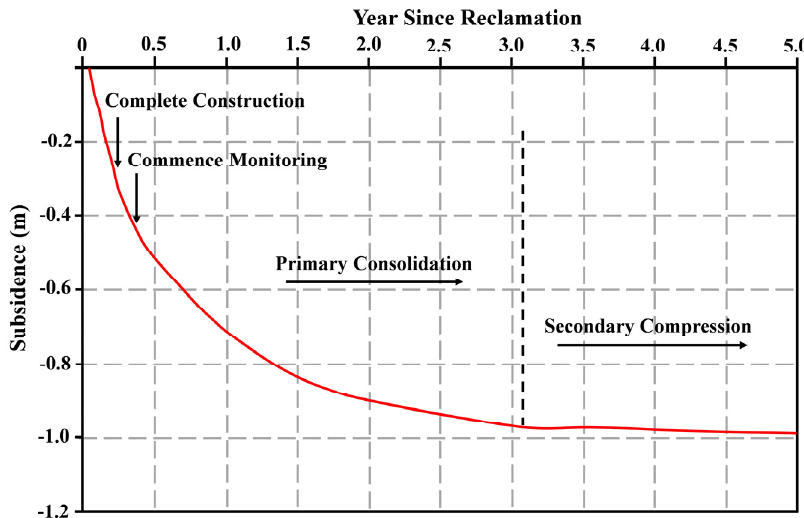
Figure 15. Typical time-settlement prediction curve of alluvial clay under the reclamation, i.e., Terzaghi theory of consolidation [10, 36].